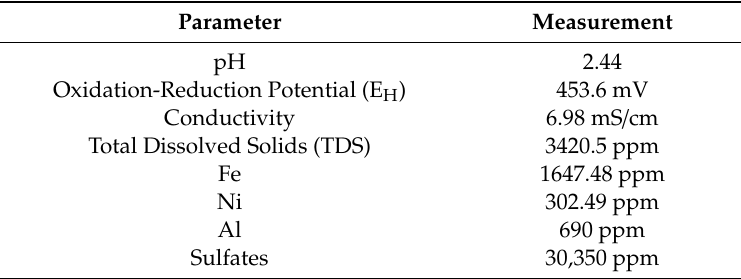
Table 2. Geochemical properties and metal content of synthetic